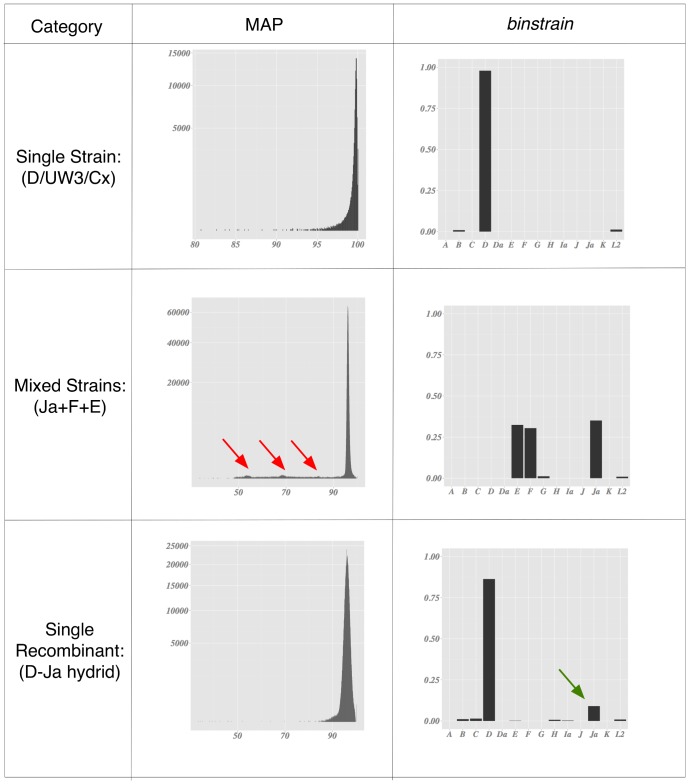
Summary of binstrain analysis of selected simulated data.Each panel illustrates representative data for (top to bottom) a single strain identical (or very similar) to a previously sequenced genome, a mixture of strains, and a single novel recombinant strain. From left to right are the histogram of Major Allele Percentage (MAP) across the sequenced region and a barplot of binstrain
β values for the reference genome set. In the MAP plots, minor peaks representing the subpopulation of mixed alleles are shown by red arrows. The minor β-value associated with the introduction recombinant strain is shown with a green arrow.